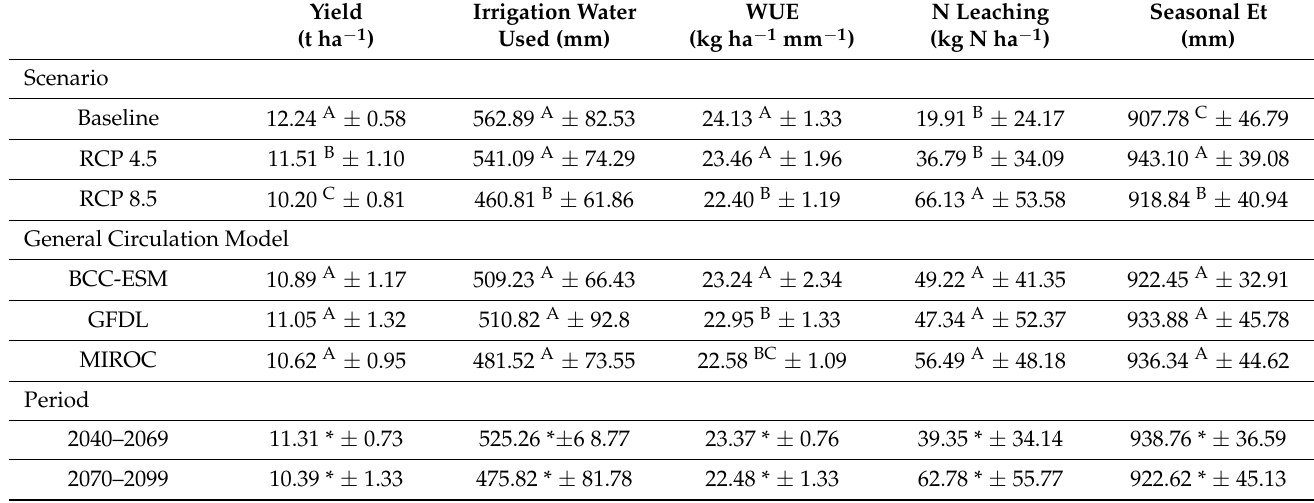
* Indicates a significant difference at α = 0.05 for independent samples t-test. WUE = water use efficiency, Et =